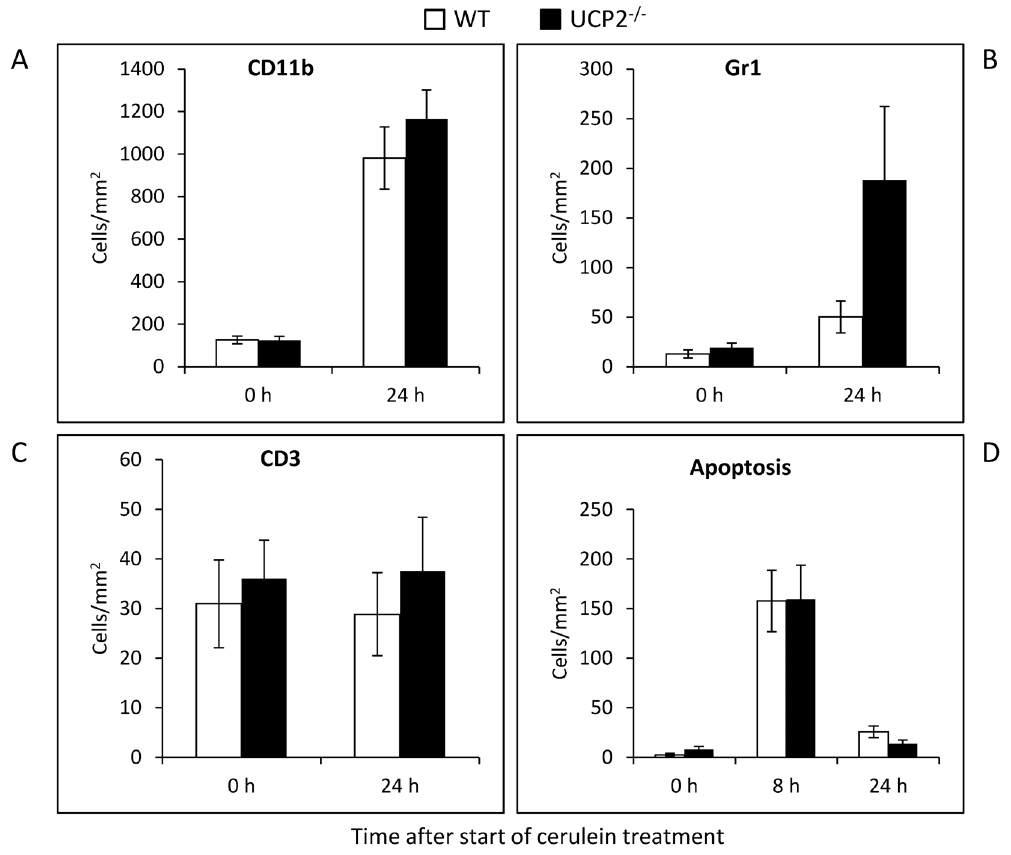
Figure 6. Immunohistochemical analysis of leucocyte infiltrates and quantification of apoptotic cells in cerulein-treated WT and UCP2 -/- mice. Pancreatic sections of 12 months old mice at the indicated time points after initiation of cerulein treatment (n=8 per group) were processed applying the ABC technique and antibodies to CD11b (A), Gr1 (B) and CD3 (C), or stained with the ApopTag Kit for the detection of apoptotic cells (D). Positive-stained cells were counted, and mean values 6 SEM were calculated. * P , 0.05 (WT versus corresponding UCP2 -/-